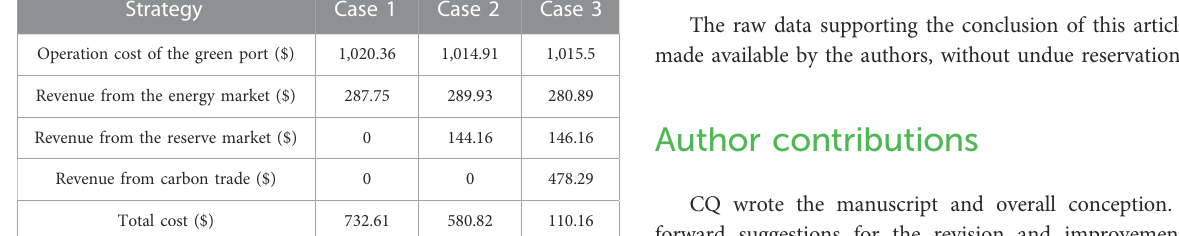
TABLE 4 Operation cost and expected pro fi t of the green port.